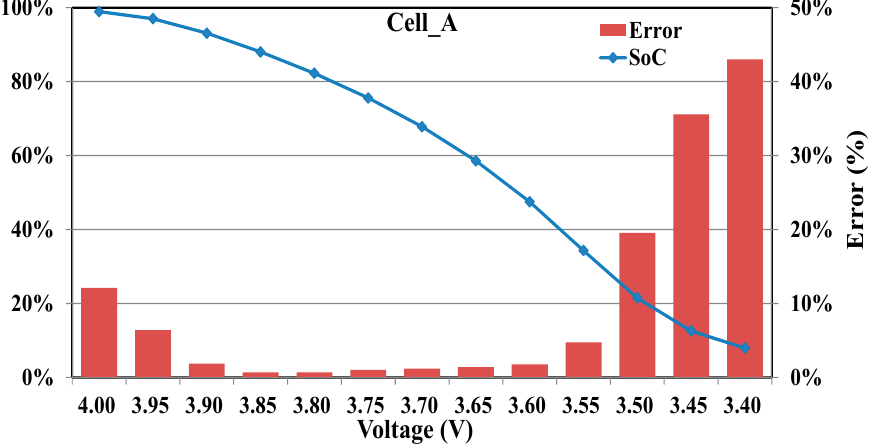
Figure 10. SOC vs. V and estimation error in the different voltage range.